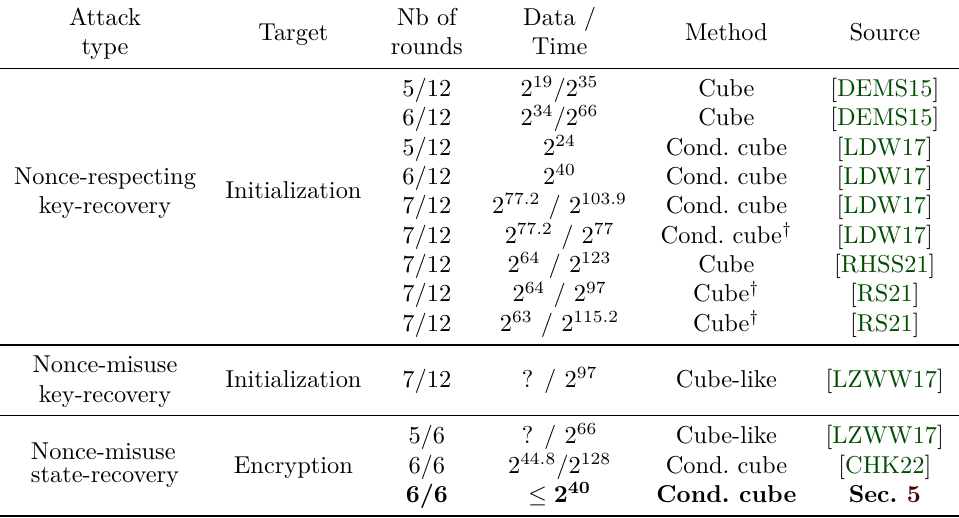
Table 1: Summary of cube-like key-recoveries and state-recoveries against Ascon